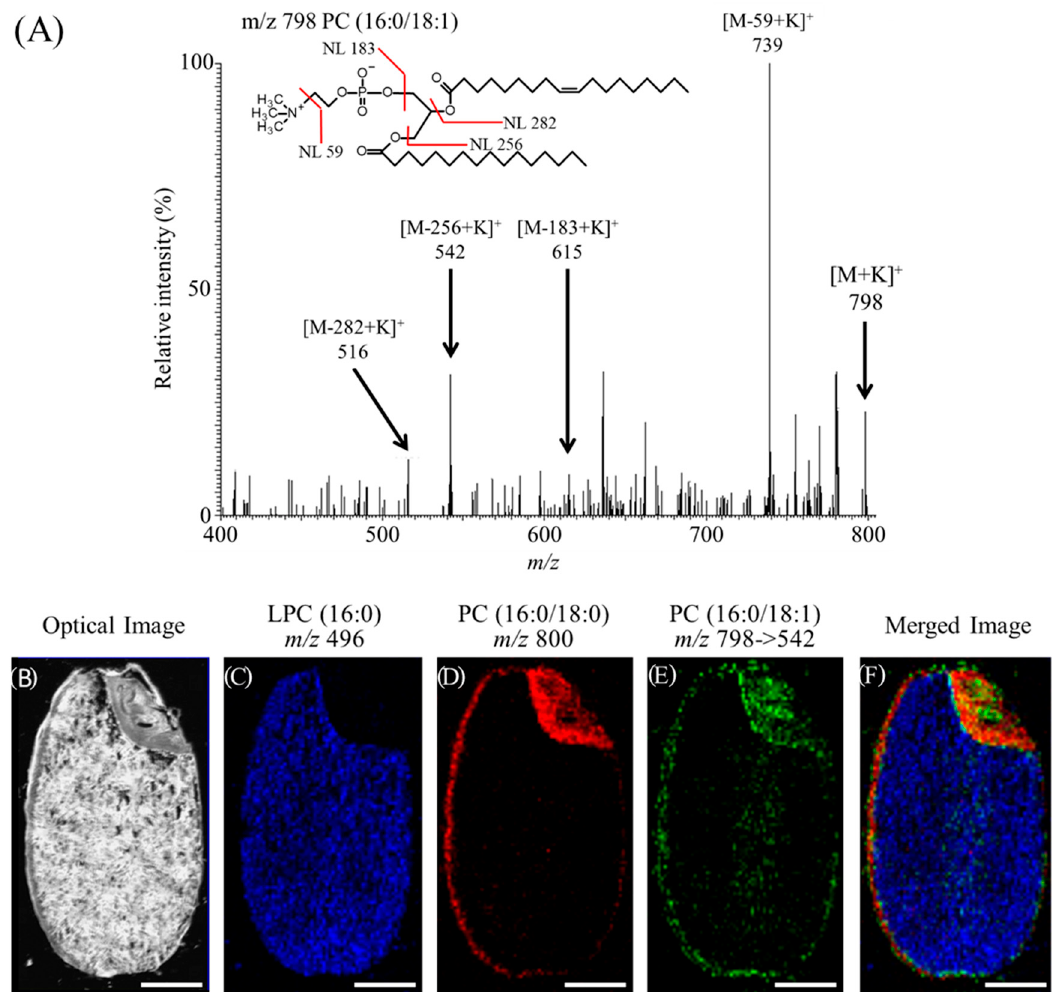
Figure 3. MSI analysis of phosphatidylcholines (PCs) containing oleic acid in a section obtained from rice seed. ( A ) MS / MS spectrum of the ions of PC(16:0 / 18:1) at m / z 798 from the rice section. Neural loss (NL) of the PC head group and fatty acids is observed. Ion image of lipids in rice ( Oryza sativa ) is shown here. Scale bar: 1 mm. ( B ) Optical image of a rice kernel (‘Hitomebore’). ( C ) Distribution of LPC(16:0). ( D ) Distribution of PC(16:0 / 18:0). ( E ) Distribution of PC(16:0 / 18:1). ( F ) Merged image of LPC(16:0) (blue), PC(16:0 / 18:0) (red), and PC(16:0 / 18:1) (green).